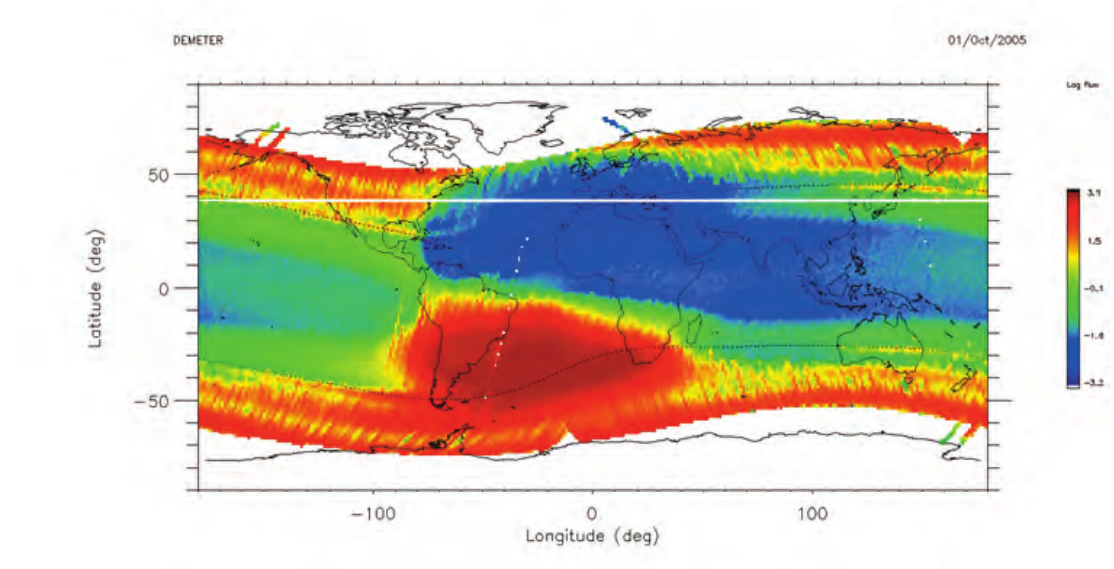
Figure 8. The average intensities of IDP/DEMETER ~200 keV energy electrons for one year (October 2005 to October 2006). The electron distribution is highly affected by the